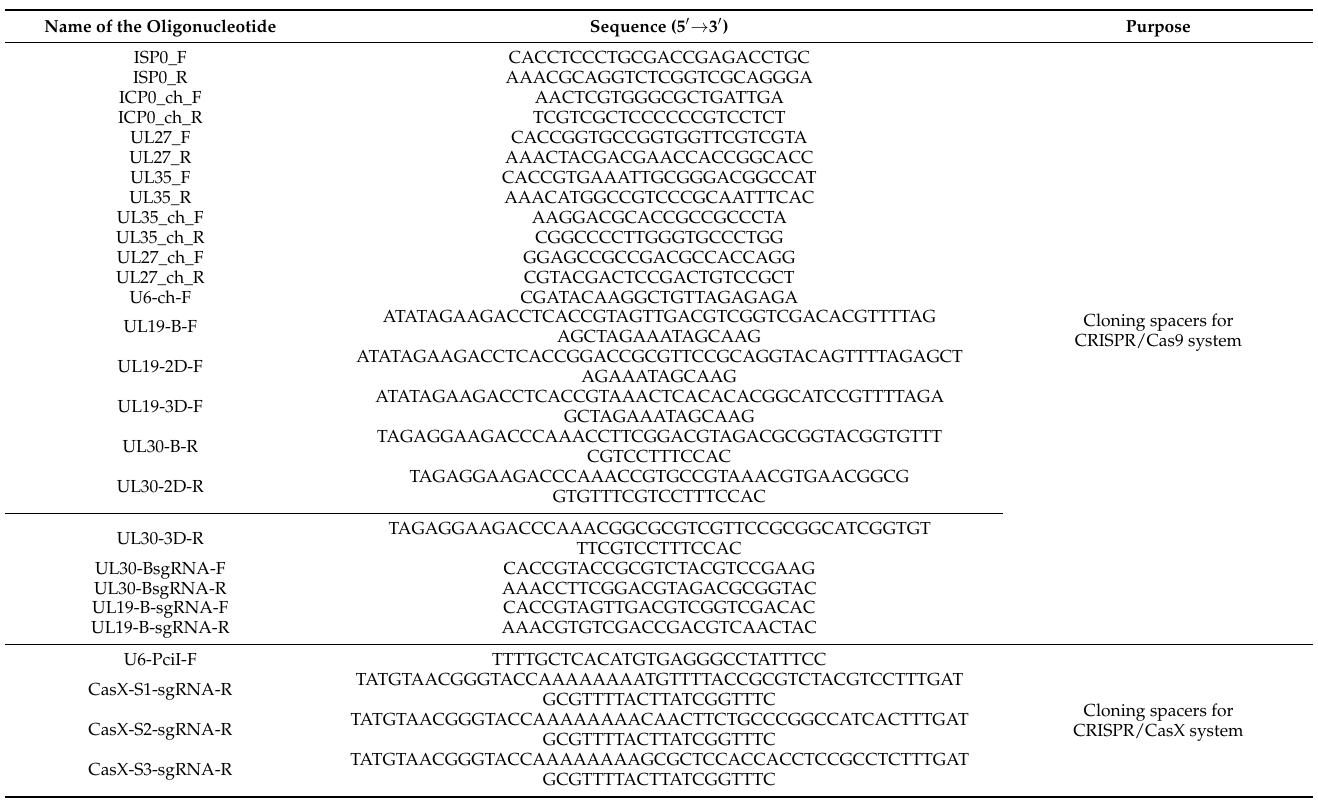
Table 2. Oligonucleotides used in the